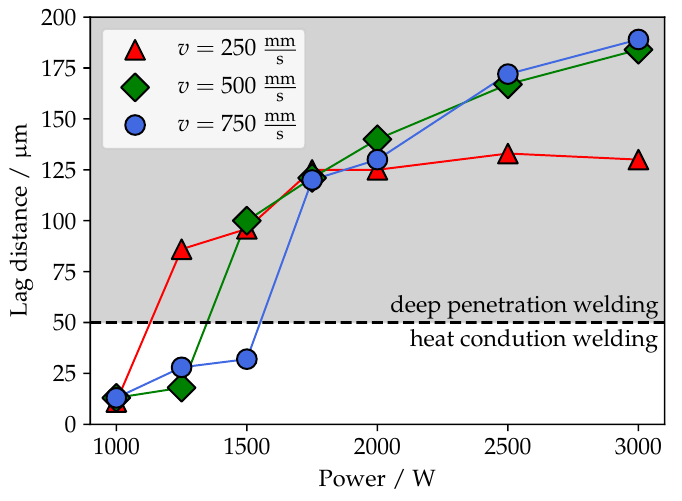
Figure 6. Optimal lag distances of the OCT beam relative to the the laser beam origin, depending on the process